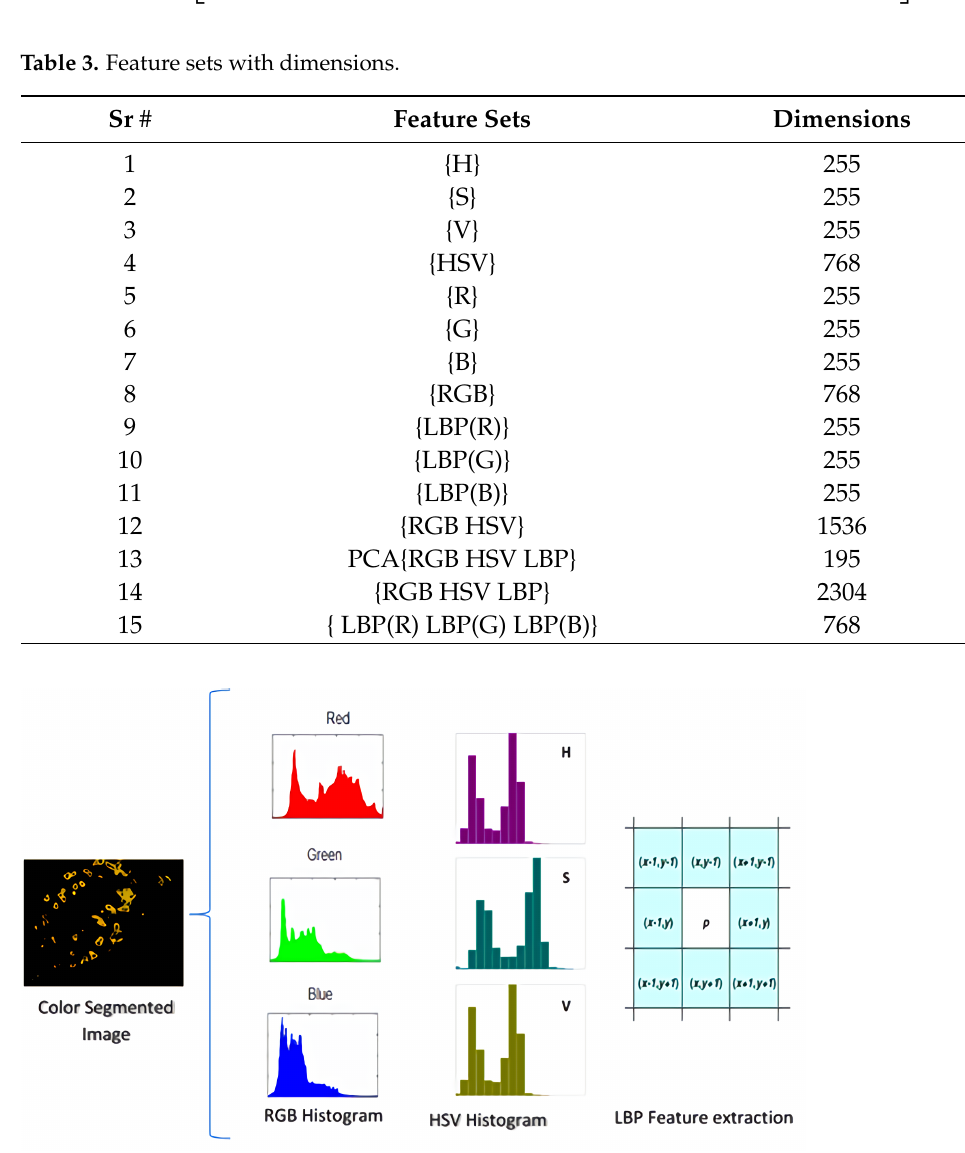
Figure 4. Illustration of HSV histograms, RGB histograms, and LBP feature